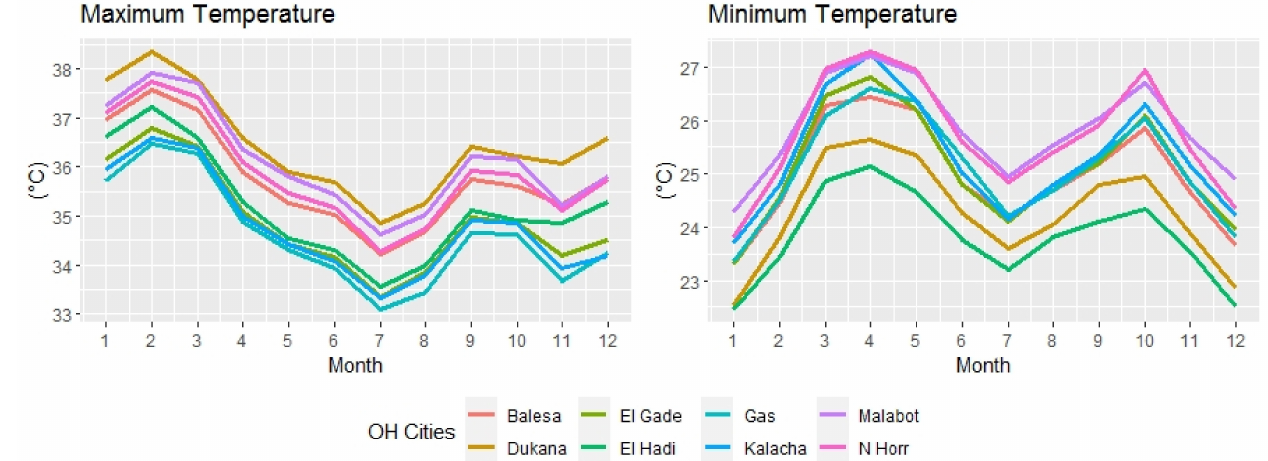
Figure 10. Annual T MAX and T MIN distribution for each reference points based on monthly ORH temperature timeseries.